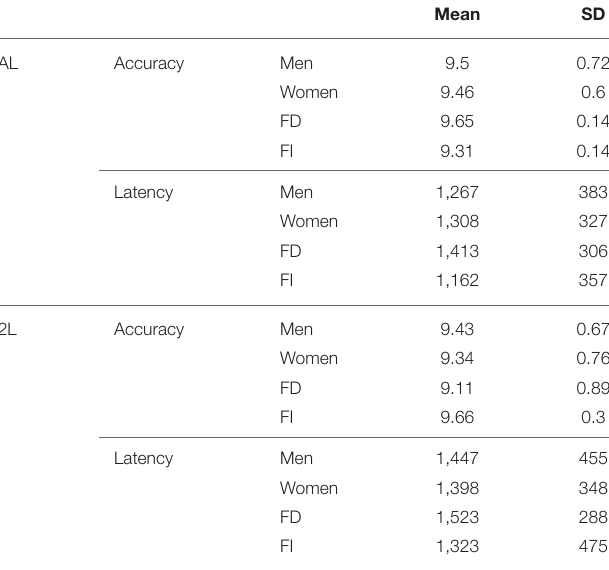
TABLE 2 | Mean and SD for gender and cognitive